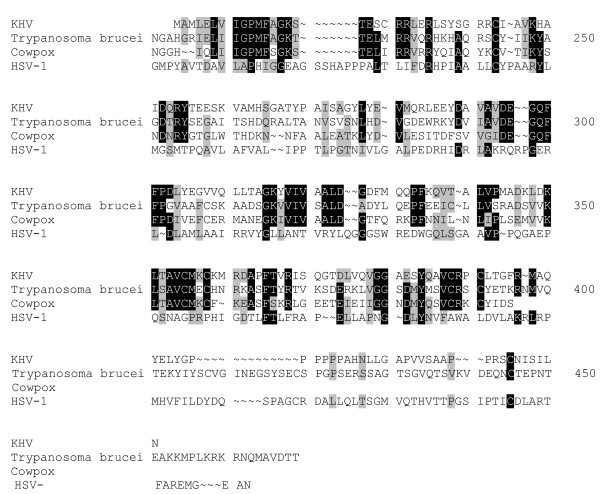
Amino acids sequence alignment of the KHV TK gene. Multiple sequence alignment of KHV TK with representative TK sequences from Poxviridae, Herpesviridae and Trypanosomatidae families, performed by the Clastall W algorithm.